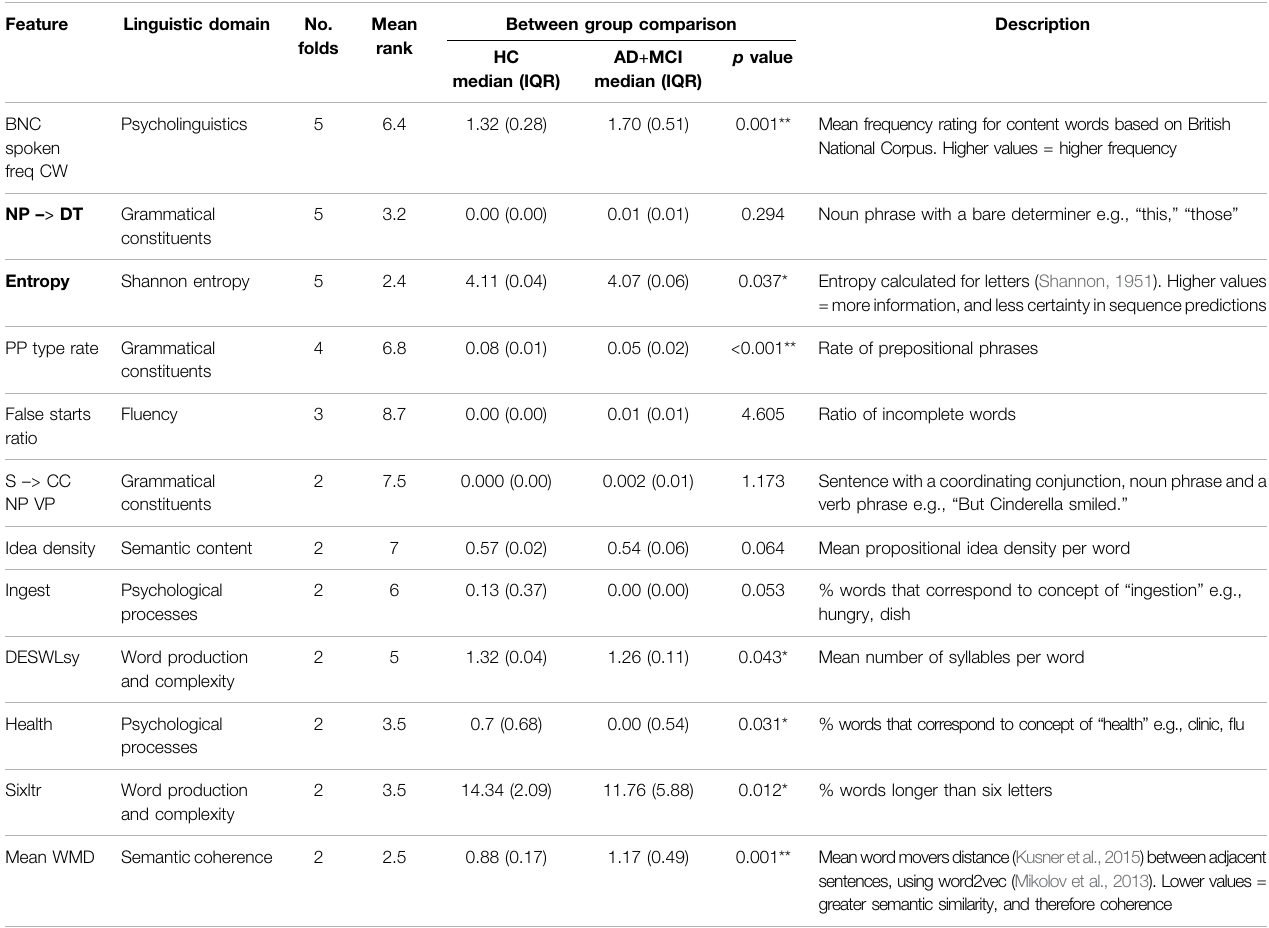
TABLE 4 | Important features of overlearned narrative recall for classifying HC vs. AD+MCI. Ordered by number of folds and then mean rank. Mann Whitney U tests Bonferroni adjusted for multiple comparisons and reported in corrected form.